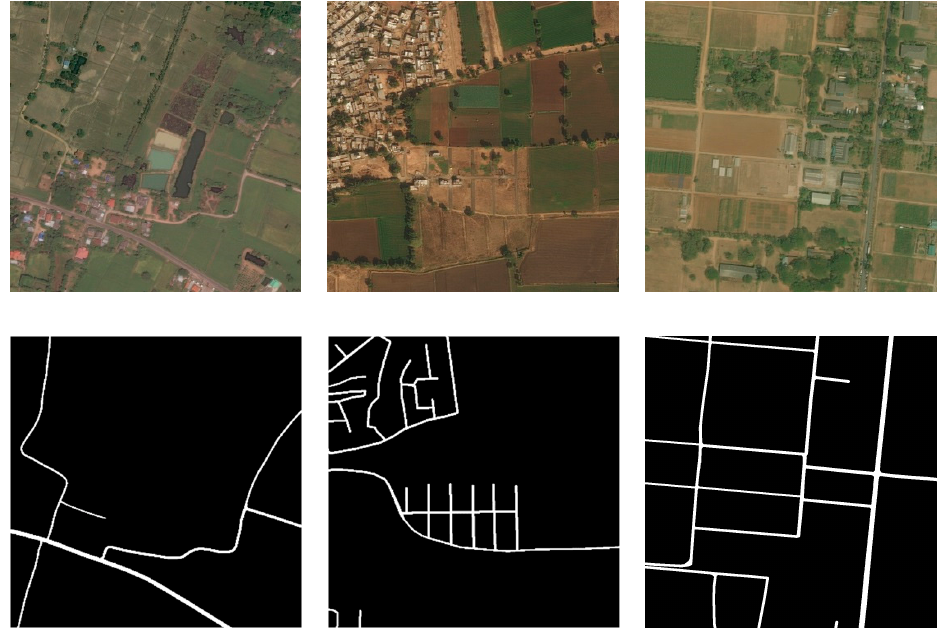
Figure 4. Sample images and labels of the DeepGlobe dataset.